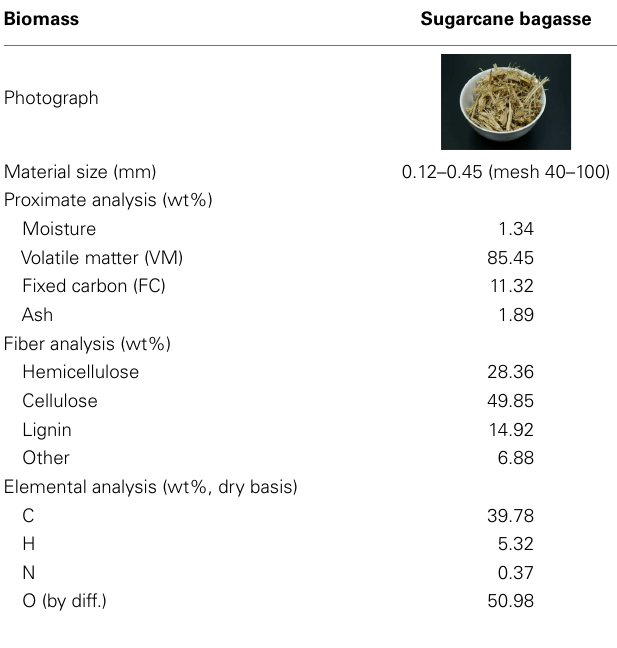
Table 1 | Photography and basic properties of raw sugarcane bagasse